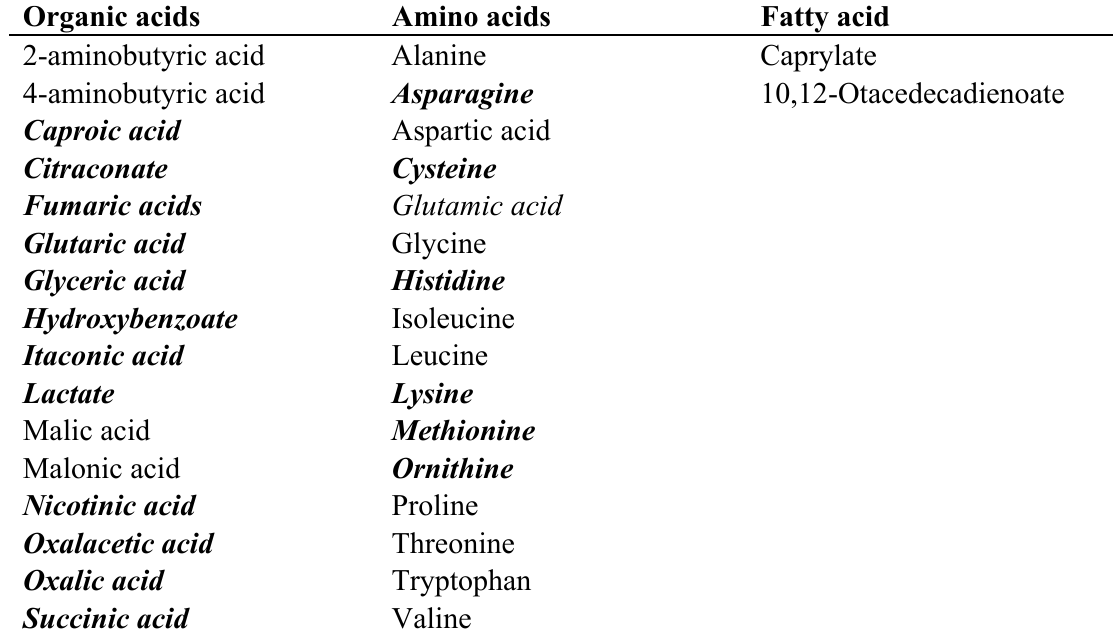
Table 2. Detected metabolites using MCF derivatization are pooled within groups. Metabolites in bold ( italic ) represent metabolites that are also detected using TMS